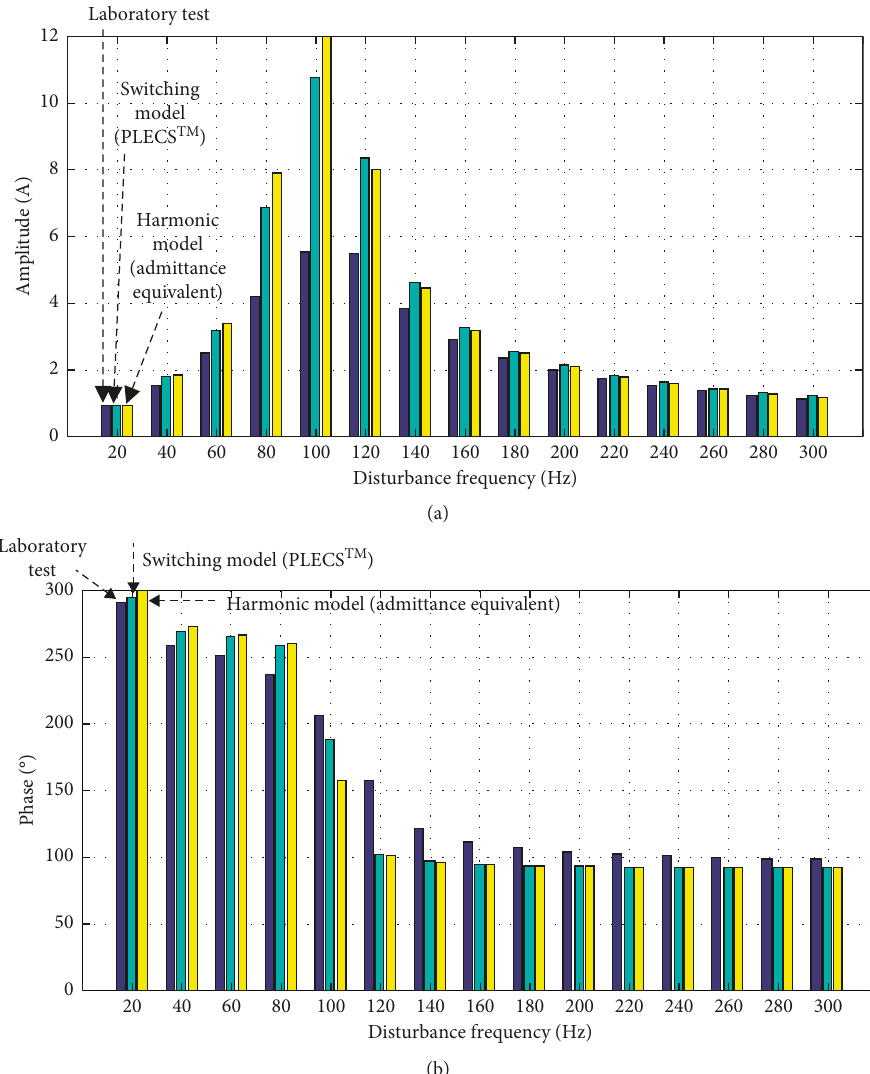
Figure 18: Harmonic spectrum of output currents for the scaled-down experiment, with 5.0V perturbation in amplitude in the range of 20 to 300Hz: laboratory test result, result generated by the switching model in PLECS ™ simulation and result generated by the proposed harmonic model. (a) Magnitude of current harmonics. (b) Phase angle of current